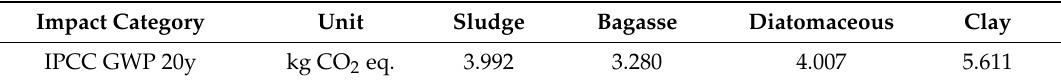
Table 5. CFP of lightweight aggregates raw material extraction and sintering process in comparison with clay and 15% mass of wastes sintered at 1000 ◦ C in terms of kg CO 2 eq. contribution. Impact Category Unit Sludge Bagasse Diatomaceous